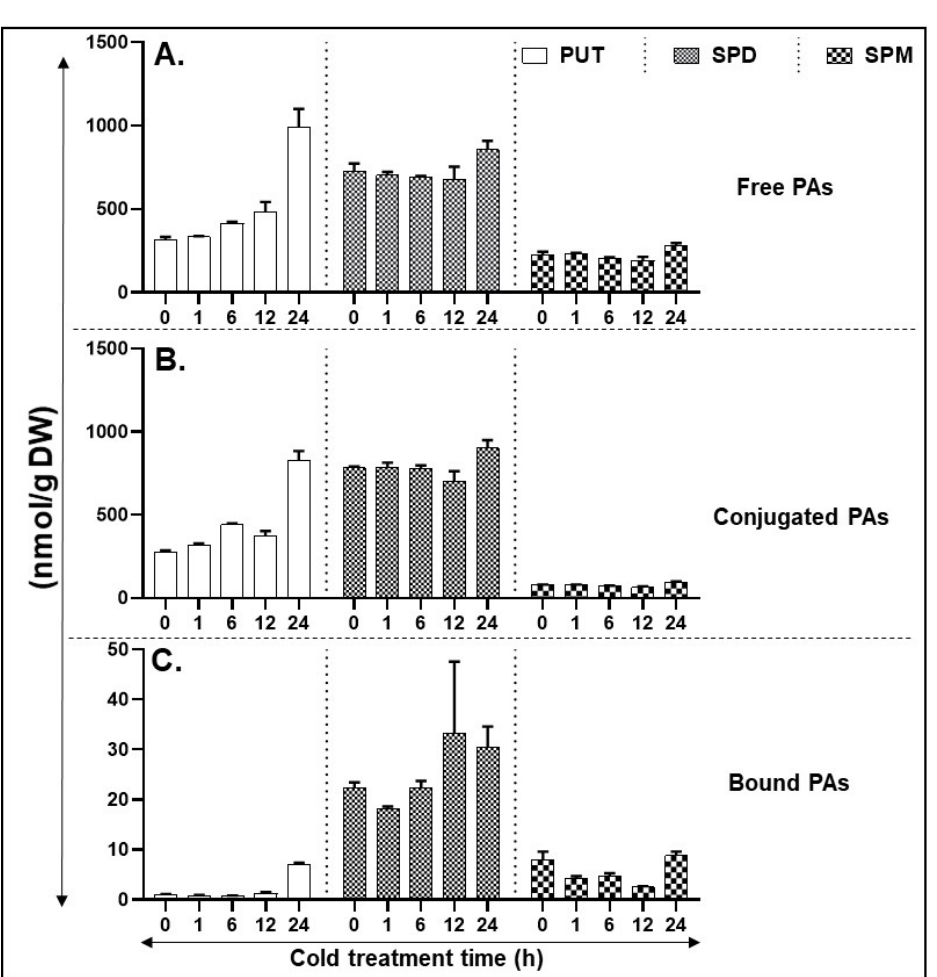
Figure 4. HPLC (High pressure liquid chromatography) based quantification of polyamines (PA) levels in cold-stressed tissues. ( A ) Free PAs—PUT, SPD, and SPM. ( B ) Conjugated PAs—PUT, SPD, and SPM. ( C ) Bound PAs—PUT, SPD, and SPM. A minimum of three leaves were excised from three plants for each biological replicate. Mean data points and standard error of a minimum of three biological replicates are shown. Statistical significance ( p -value) was derived using Graph prism pad program via Tukey test/t-test.